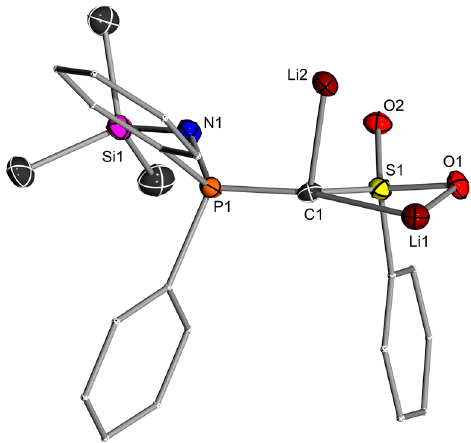
Figure 7. Monomeric subunit of methandiide 1-Li 2 . Ellipsoids drawn at the 50% probability level. Hydrogen atoms omitted for clarity. Selected bond lengths (Å) and angles (°): C1–S1 1.601(3), C1–P1